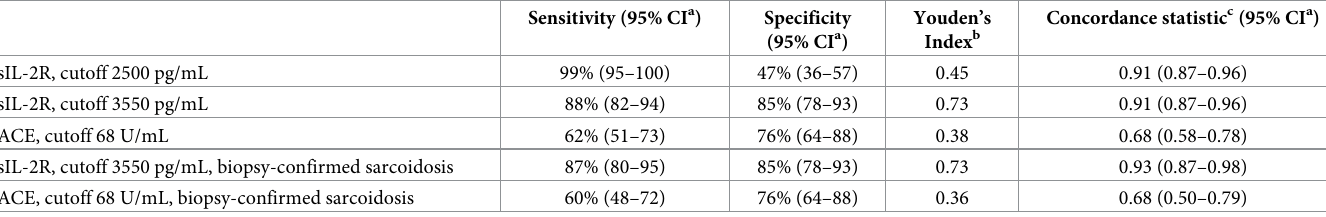
Table 2. Sensitivity, specificity, Youden’s index and concordance statistic in the diagnosis of